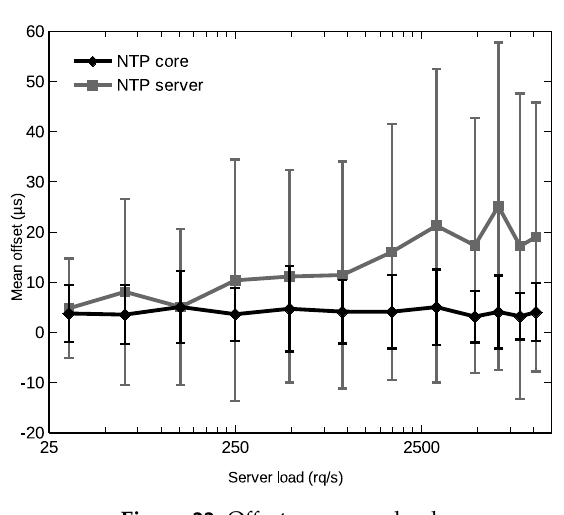
Figure 22. Offset vs. server load.